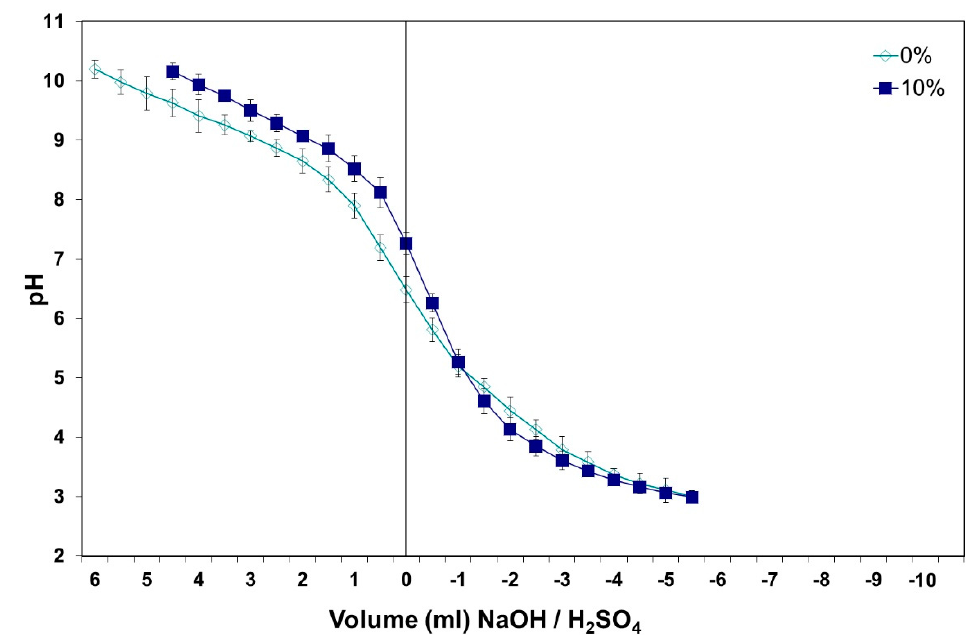
Figure 4. Oak species influence on the pH and buffer capacity of an oak/pine wood mixture, after defibering and gluing with a urea-formaldehyde (UF) resin.